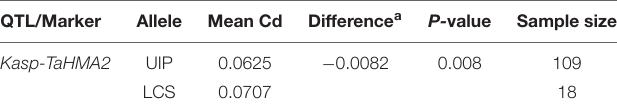
TABLE 8 | Allelic effect of TaHMA2 on grain Cd content in 127 diverse spring wheat lines grown in 17SS. QTL/Marker Allele Mean Cd Difference a P- value Sample